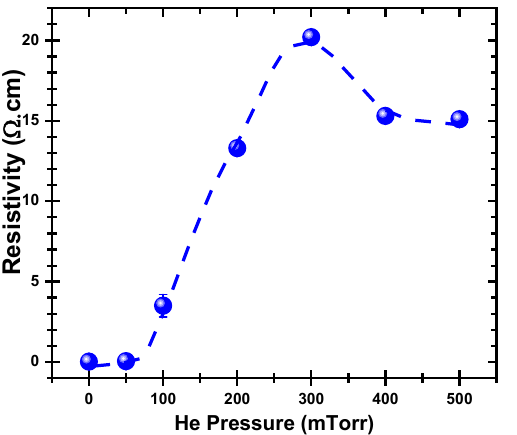
Figure 6. ( a ) UV-Vis absorbance spectra of PbS films deposited (at N LP = 3500) onto quartz substrates at different helium background pressures. ( b ) Associated Tauc-plots from which the optical bandgap values were derived; ( c ) Variation of the optical bandgap of PLD-PbS films with background He pressure.